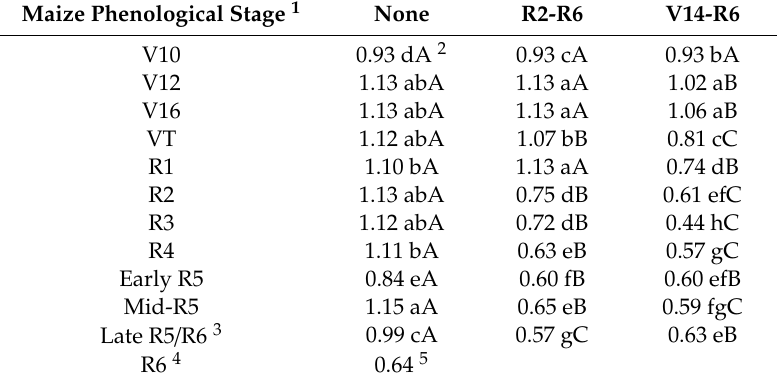
Table 6. Actual basal crop coe ffi cient (K ab ) by maize phenological stage for treatments with no drought stress (None), drought stress from the blister maize phenological stage (R2) to maize physiological maturity (R6) (R2-R6), and drought stress from the 14 leaf collar maize phenological stage (V14) to R6 (V14-R6), across hybrids in the experiment where maize followed soybean and received the optimal nitrogen